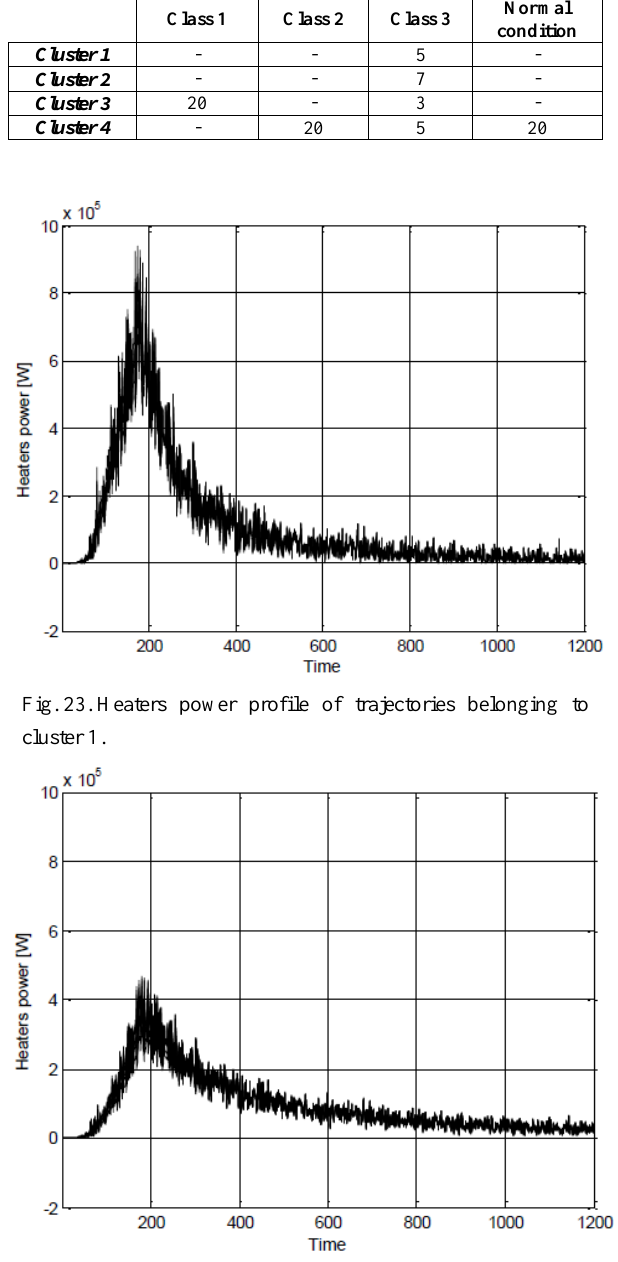
Fig. 24. Heaters power profile of trajectories belonging to cluster 2.